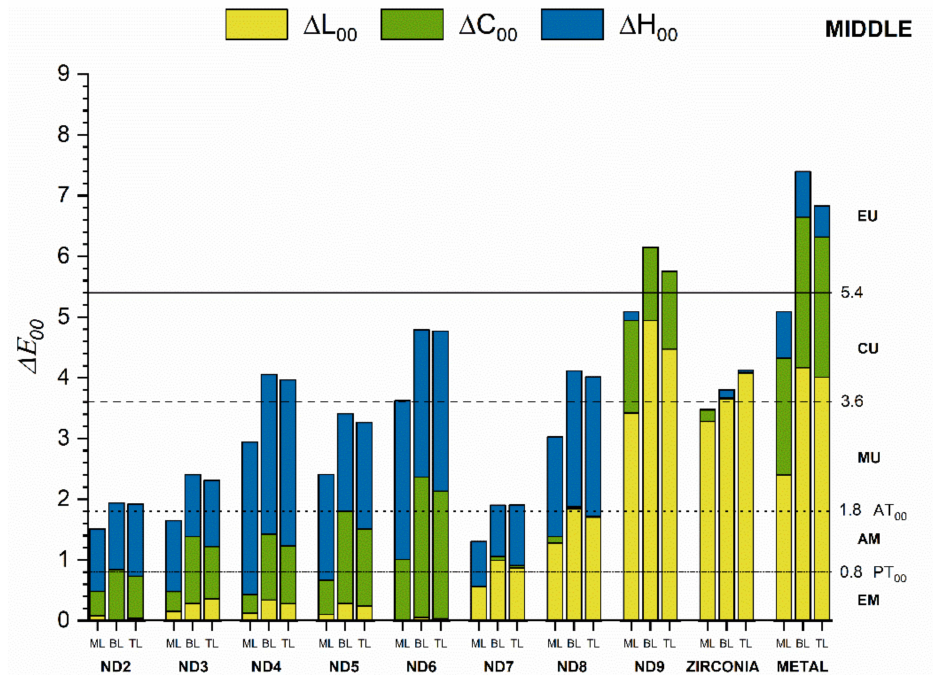
Figure 7. Masking ability of crown groups on different substrates evaluated for the middle